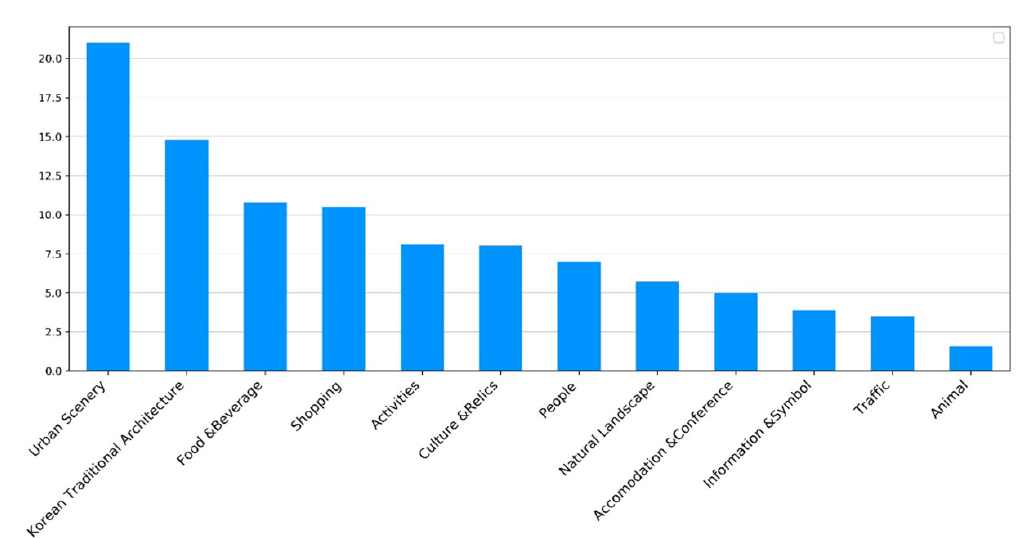
Figure 11. Percentage of photos by 12 categories in descending order.